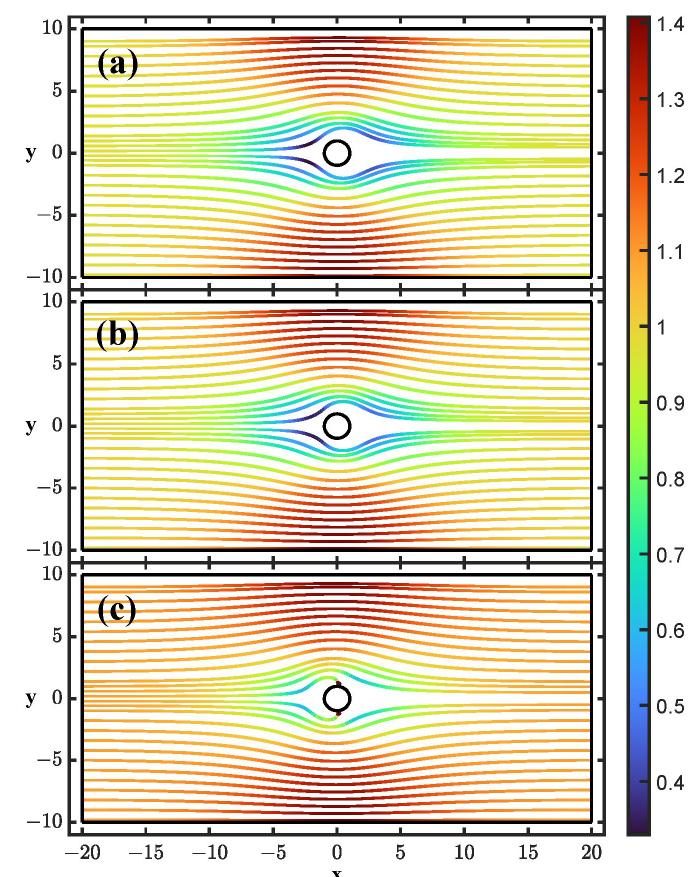
Figure 2. Particle trajectories for an applied electric field parallel to flow direction: ( a ) Low frequency and Λ = 1. ( b ) Low frequency and Λ = 0.5. ( c ) High frequency. The colors represent the magnitude of the particle velocity in units of v 0